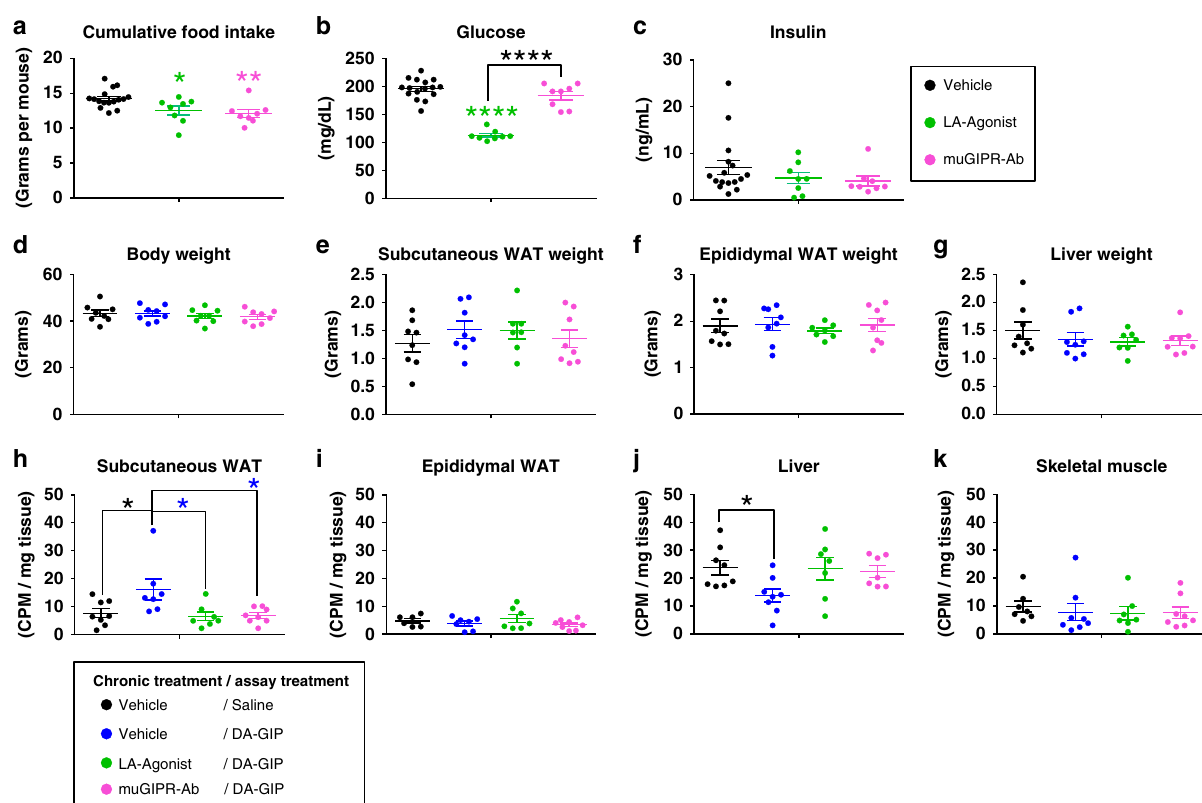
Fig. 9 Chronic GIPR agonism desensitizes adipocyte GIPR activity in vivo mimicking GIPR antagonism. GIP-stimulated FA uptake in DIO mice treated with vehicle, LA-Agonist, or muGIPR-Ab for 6 days. On day 6, mice were injected with saline or DA-GIP and simultaneously oral gavaged with 14 C-oleic acid in olive oil to assess FA uptake. a Cumulative food intake determined; * p = 0.036, ** p = 0.0075. b Fasting blood glucose and c plasma insulin were measured on day 6; **** p ≤ 0.0001. Data represent means ± SEM of 16 mice for vehicle group (divided into two groups of 8 for the FA uptake assay) and eight mice/group for the LA-Agonist and muGIPR-Ab groups. d Body weight, e scWAT weight, f eWAT weight, and g liver weight were measured at necropsy on day 6. Radioactivity uptake into metabolically relevant tissues was determined at necropsy in h scWAT, i eWAT, j liver, and k skeletal muscle. h Vehicle/DA-GIP vs. Vehicle/Saline * p = 0.027, Vehicle/DA-GIP vs. muGIPR-Ab/DA-GIP * p = 0.014, Vehicle/DA-GIP vs. LA-Agonist/DA-GIP * p = 0.014; j * p = 0.041. n = 8 mice/group. a – k One-way ANOVA with Sidak ’ s test for multiple comparisons; * p ≤ 0.05, ** p ≤ 0.01, and **** p ≤ 0.0001. Data are presented as mean values ±